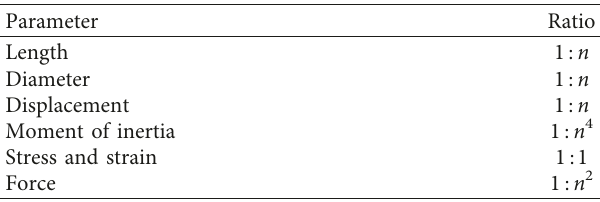
Figure 5: TLJ-3 type geotechnical centrifugal. Table 6: Similitude ratios in centrifugal model